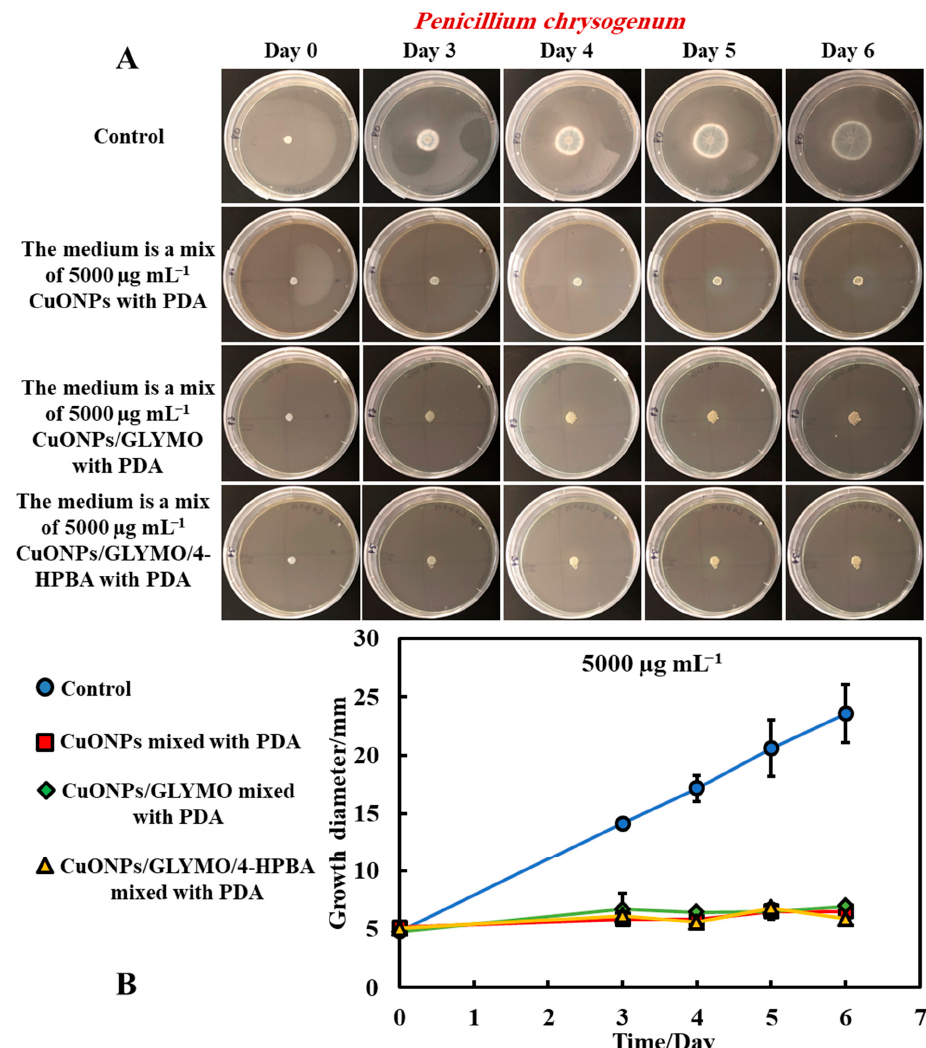
Figure 5. ( A ) Digital photographs of the Petri dishes with PDA medium containing P. chrysogenum in the center and with antimould agent at concentration of 5000 µg mL − 1 CuONPs (bare or functionalized) mixed with the PDA growth medium and incubated for six days, at 25 °C. ( B ) Growth of a circular spot of seeded P. chrysogenum as a function of time for three different types of antimould nanoparticles: bare CuONPs, CuONPs/GLYMO and CuONPs/GLYMO/4-HPBA applied to the medium, according to Method 3. The solid lines are guides to the eye.